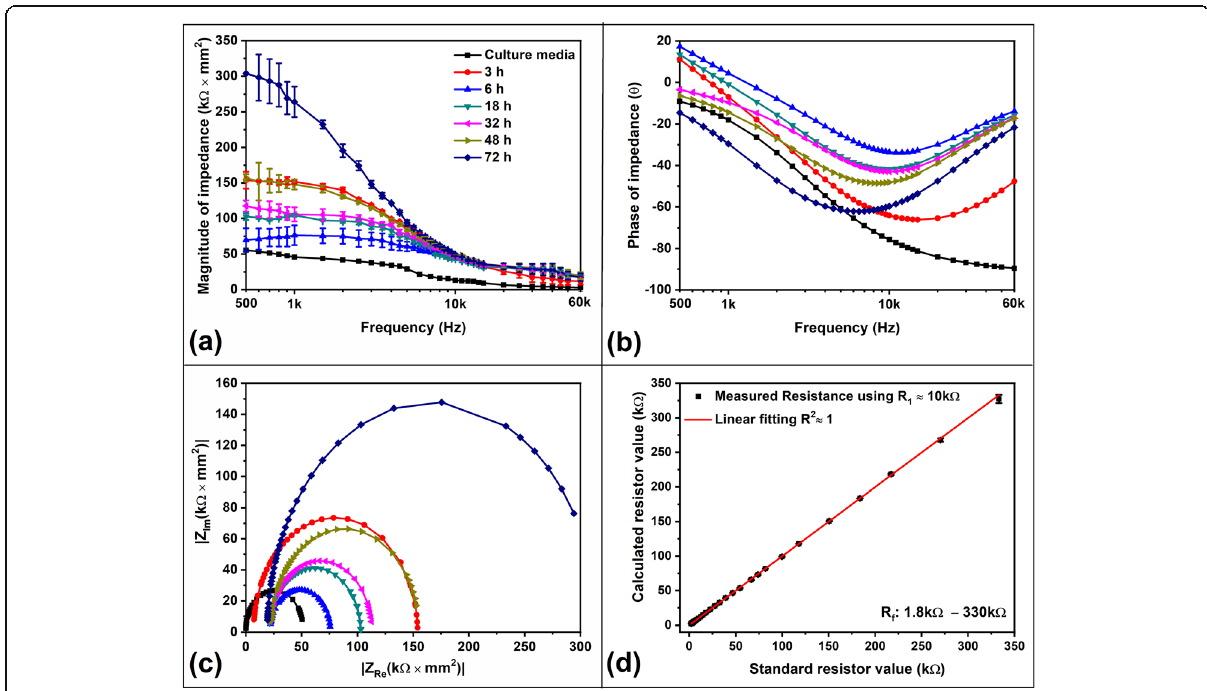
Fig. 4 Change in cell proliferation with respect to average magnitude of impedance over the calibrated area. a Frequency vs. magnitude. b Frequency vs. phase. c Cole-Cole plot shows the change in semi-circle diameter due to the change in transfer of electrons between the metal- electrode interface resistance. d A calibration plot using commercially available resistors shows that the developed system is capable of measuring the impedance value with an accuracy of about R 2 =